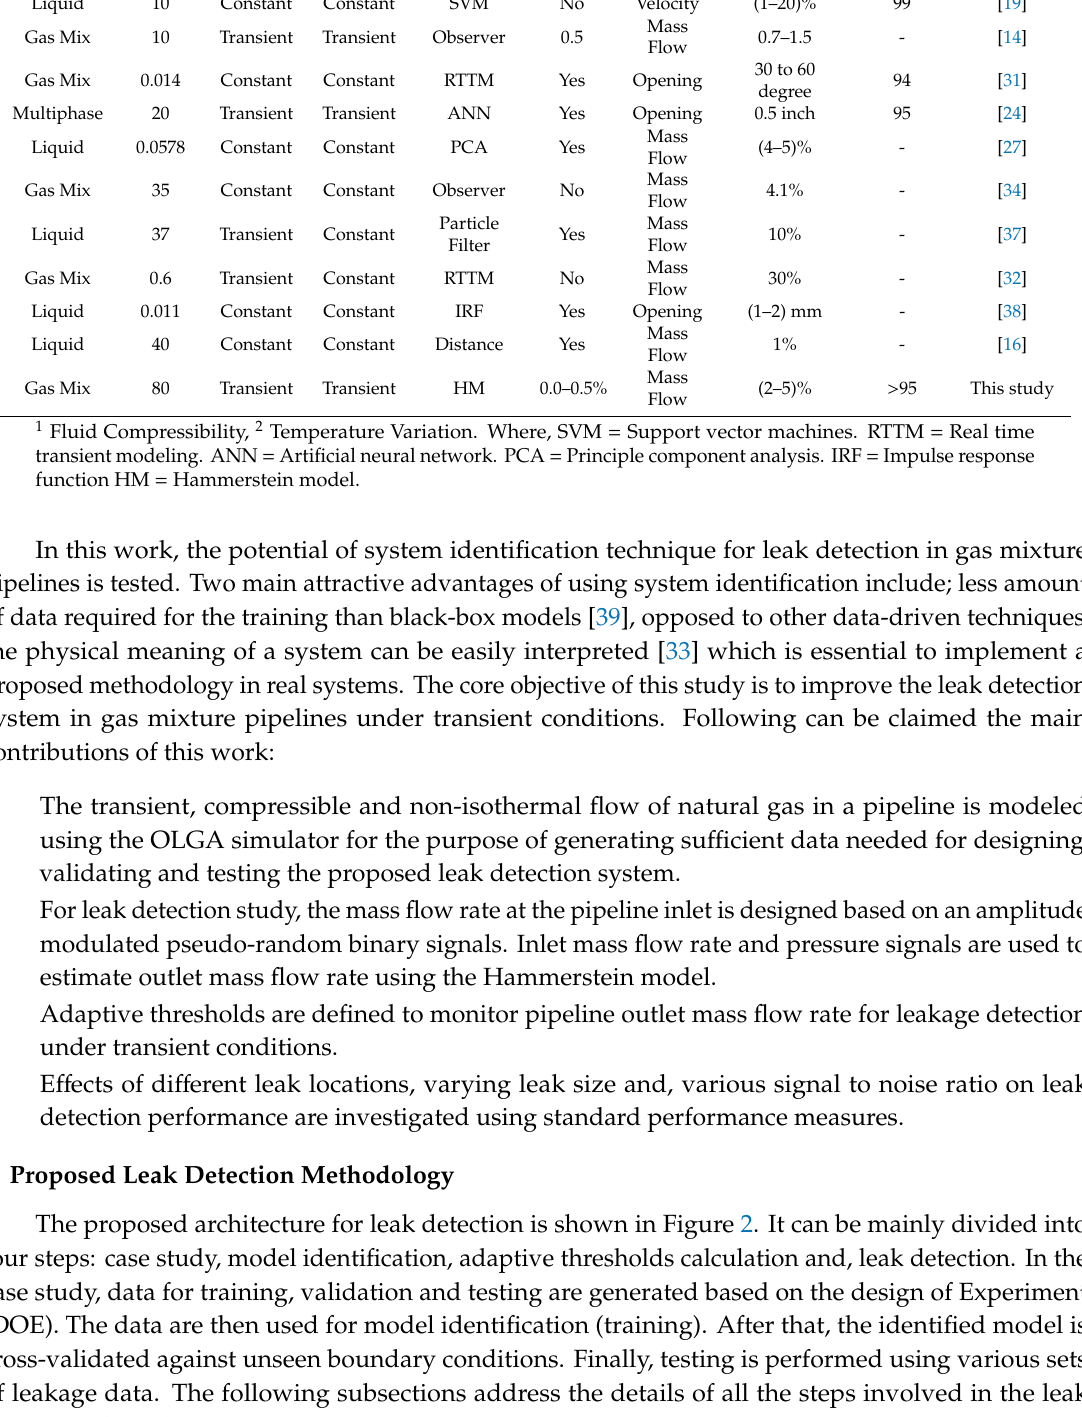
Table 1. Variations in the parameters used by previous studies on pipeline leak detection.